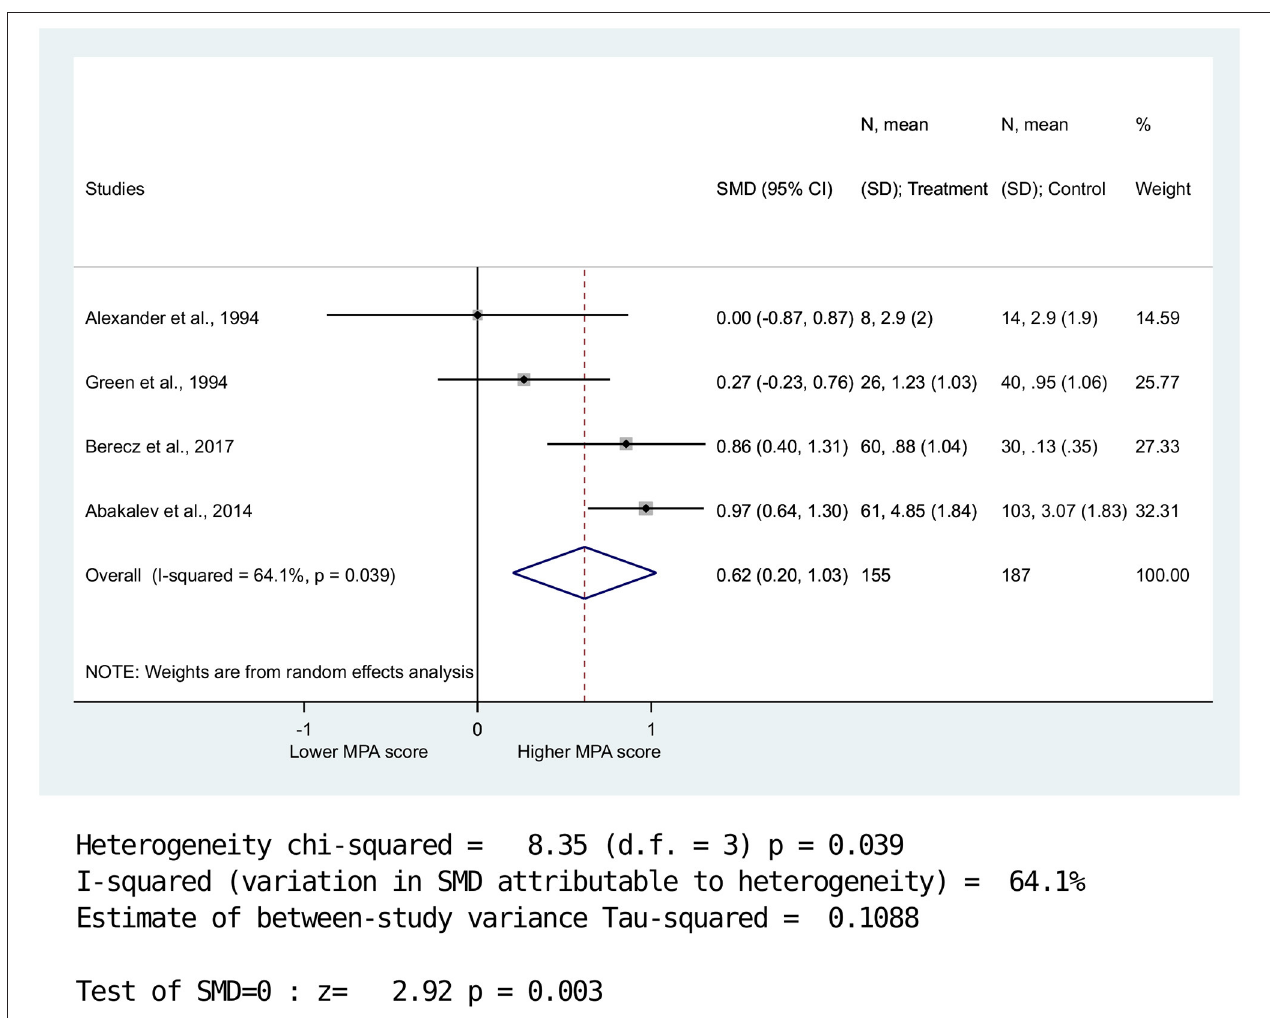
FIGURE 2 | Standardized mean difference of minor physical anomalies in patients with bipolar disorders vs. healthy controls. There was significantly higher total MPA scores in BPD compared to HC. (SMD = 0.62, 958%; CI: 0.20-1.03, p = 0.003).